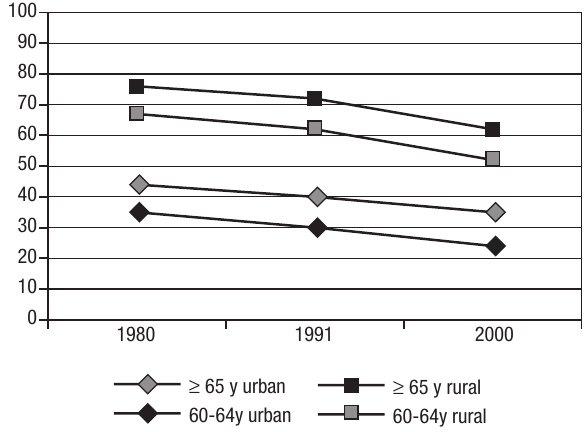
Figure 1. Illiteracy rates by age group, and urban or rural